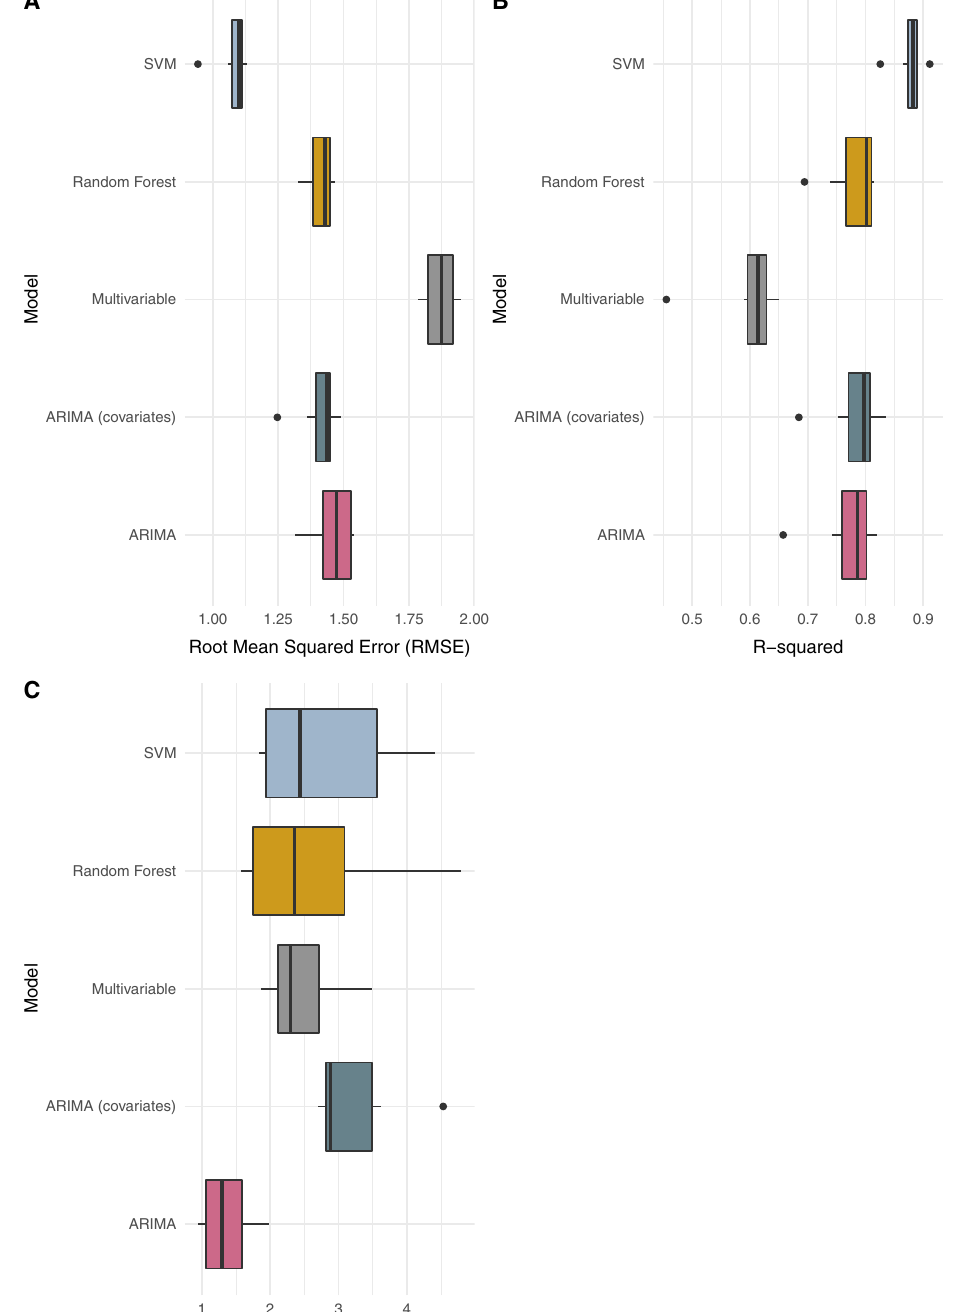
results across the regions. At the national level, search terms (SI Table 1) that had correlations of 0.3 or greater with ILI were used as explanatory variables in the models. These included, catarrh, pain, douleur (pain), tran- spire (sweat), gingembre (ginger), miel (honey), tea, malaria, paludisme (malaria), TB, AIDS, and HIV. SVM had the lowest mean RMSE and the highest mean R 2 —1.078 and 0.877, respectively (Fig. 2A,B). RF had a mean RMSE of 1.41 and R 2 of 0.781. The ARIMA model that did not include the search terms as explanatory vari- ables had comparable RMSE and R 2 to Random Forest and the ARIMA model with explanatory variables. The